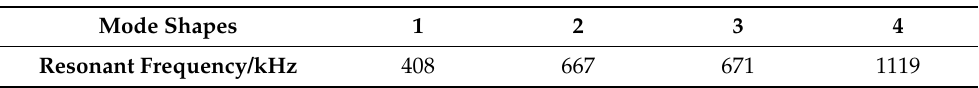
Table 1. Resonant frequencies of the four